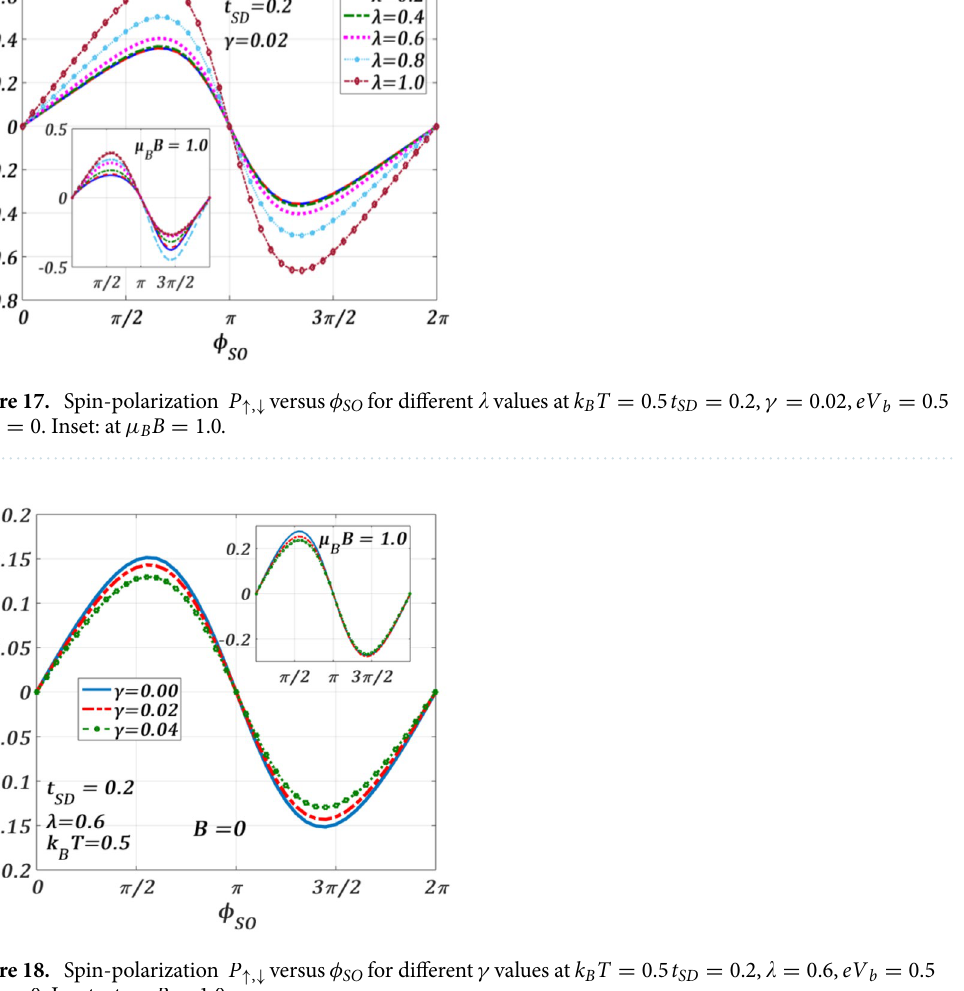
versus φ SO for different γ values at k B T , ↑ ↓ 1.0 =